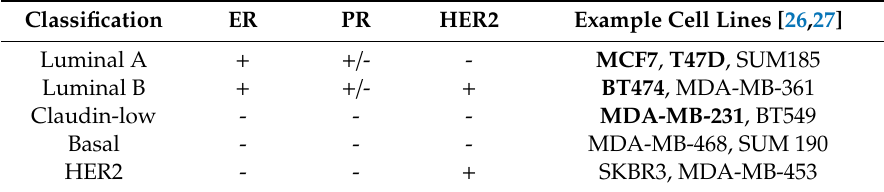
Table 1. Molecular classification of breast cancer cell